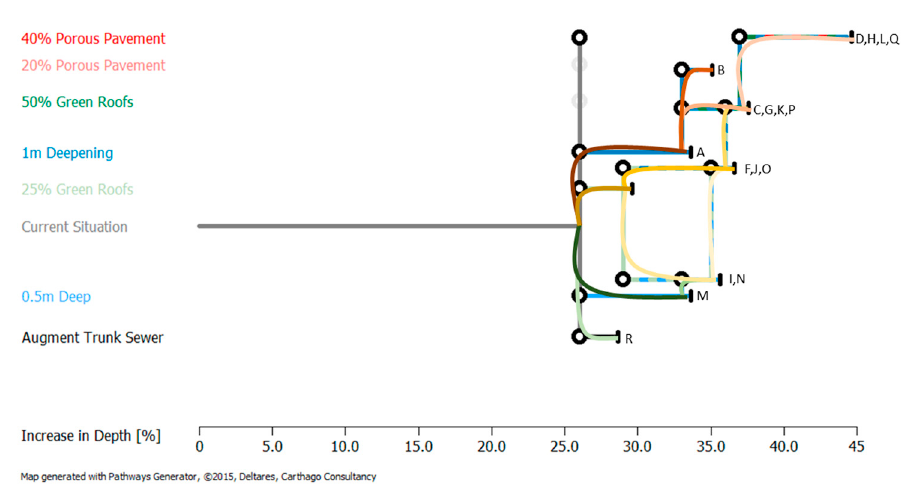
Figure 3. Potential paths through the adaptation tube map.